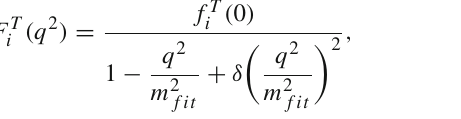
Table 3 The branching ratios of the (cid:2) QQ → (cid:3) Q (cid:4) + (cid:4) − decays